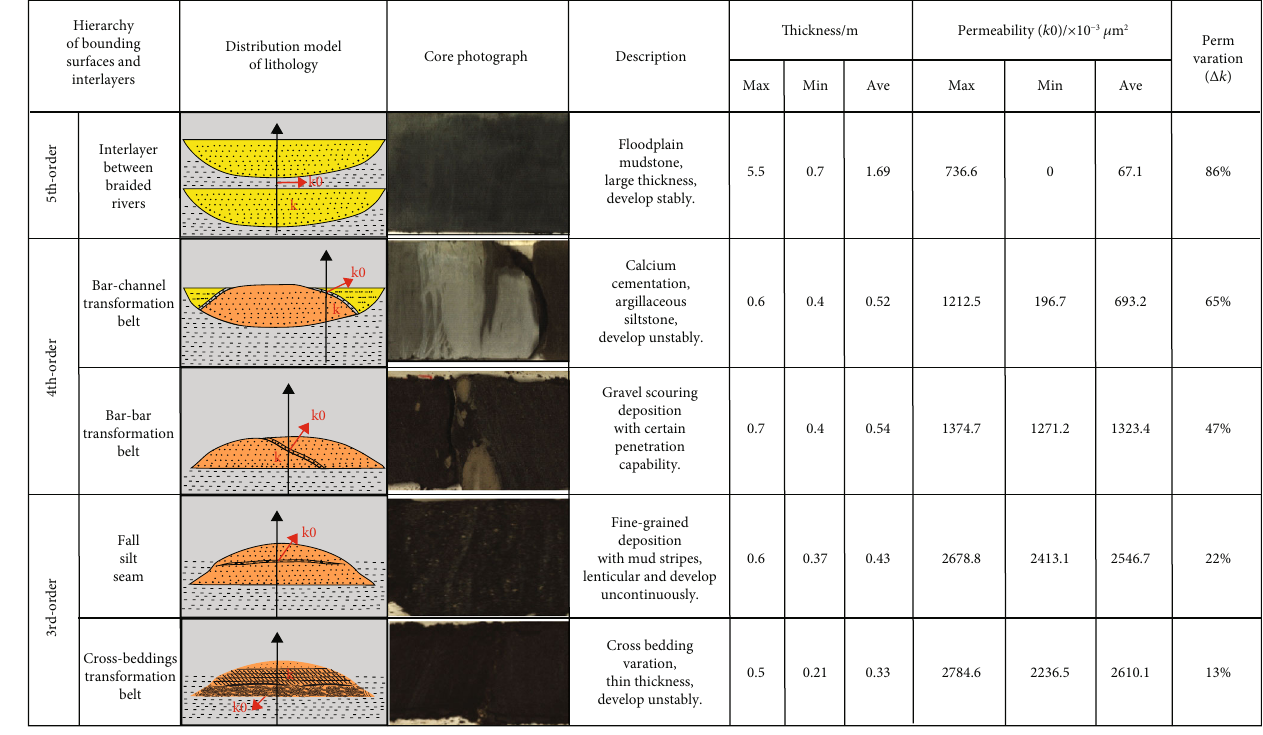
Figure 7: Depositional model and physical properties characteristics of hierarchical bounding SP curve shows a clear baseline segment, and the ML logging curve also has noticeable returns.